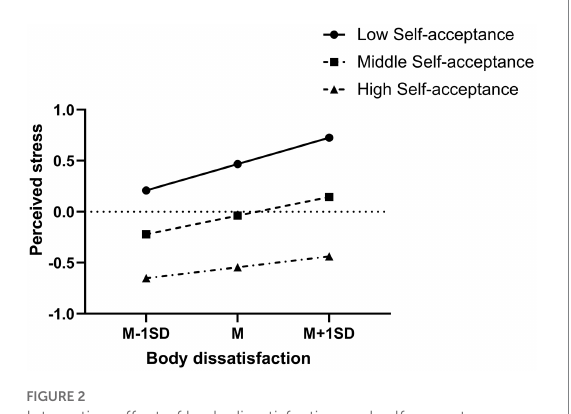
FIGURE 2 Interaction effect of body dissatisfaction and self-acceptance on perceived stress. High and low levels of body dissatisfaction and self-acceptance represent one standard deviation above and below the mean,